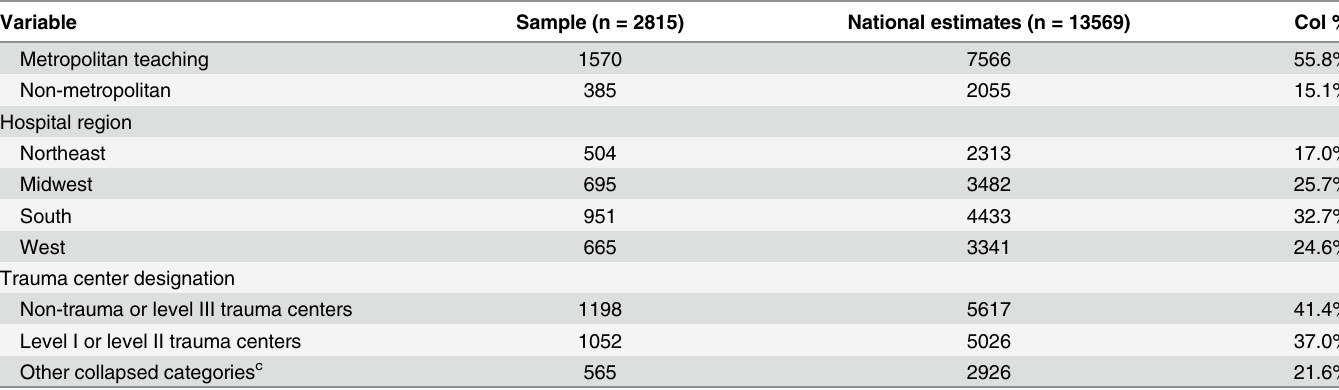
Abbreviations: NEDS, Nationwide Emergency Department Sample.